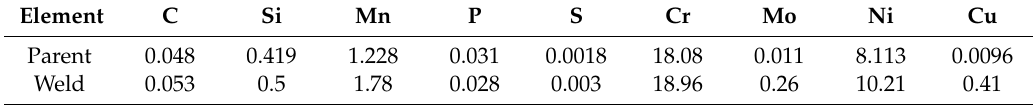
Table 1. The chemical compositions of the parent metal and the filler wire (wt %).